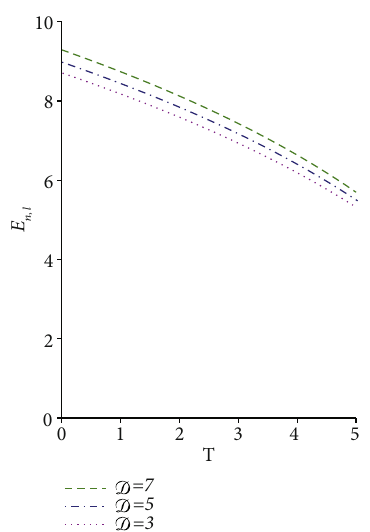
n with μ = c = ℏ Figure 4: Variation of the energy E Figure 6: The contribution of the coupling strength to the energy n , ℓ in terms of = 1 , Η = 20 , ϱ = 0 : 1 , Τ = 10 , and σ = 0 : 1 for D = 3 , 5, and 7. spectra with μ = c = ℏ = 1 , Η = 10 , σ = 0 : 1 , and ϱ = 0 : 1 for D = 3 , 5, and 7